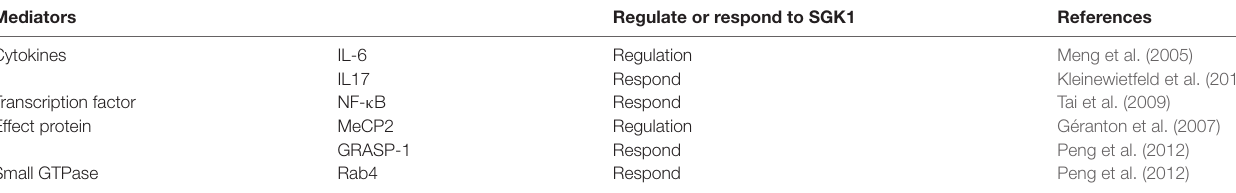
TABLE 1 | Inflammatory mediators that regulate or respond to serum and glucocorticoid-inducible kinase 1 (SGK1) inflammatory pain.